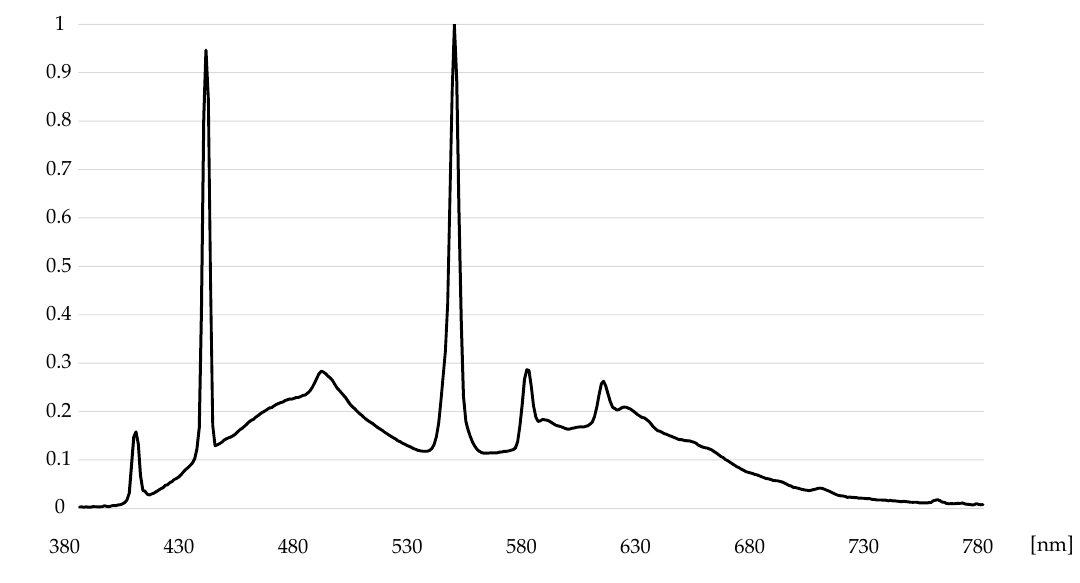
Figure 3. The normalized spectral power function of patch No. 1.